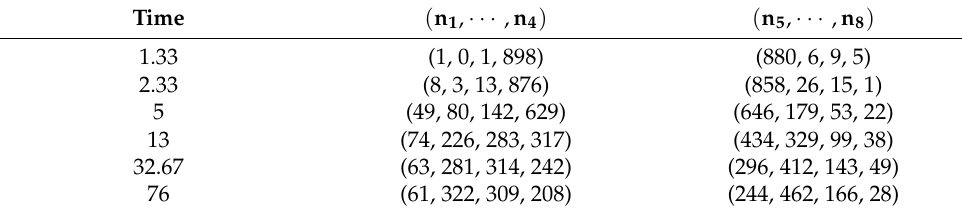
Table 6. The table provides the response frequencies from experiment 2 in [17] for each temporal